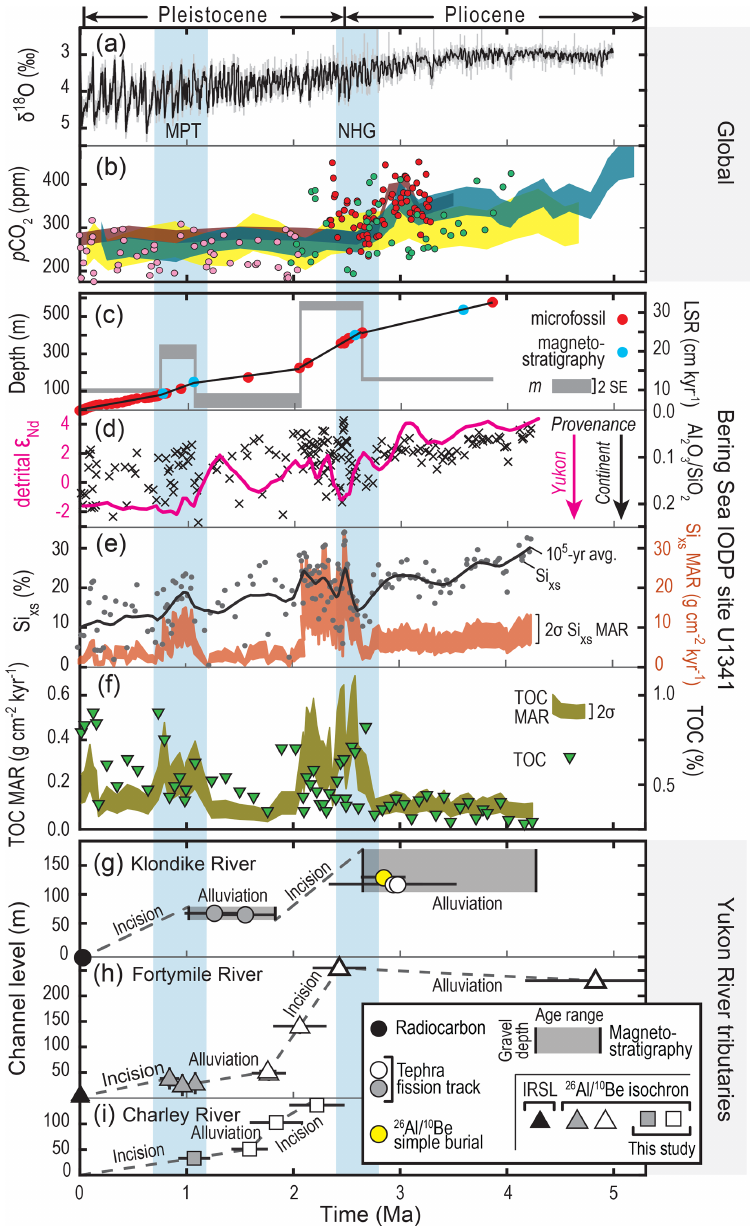
Figure 4. Late Cenozoic changes in global climate, Bering Sea sedimentation, and Yukon River tributary incision. (A) Global benthic δ 18 O (black line) and standard deviation (gray bars) (Ahn et al., 2017). (B) Atmospheric p CO 2 reconstructed from δ 11 B (red (Martínez-Botí et al., 2015), green (Bartoli et al., 2011), and pink (Hönisch et al., 2009) dots; blue envelope (Seki et al., 2010)) and alkenones (brown (Seki et al., 2010) and yellow (Pagani et al., 2010) envelopes). (C) Bering Sea integrated ocean drilling program (IODP) Site U1341 depth–age data (colored dots (Horikawa et al., 2015; Iwasaki et al., 2016)), regression model (black lines). Thick gray line plots regression model slope m and standard error (SE), which signify linear sedimentation rate (LSR) and uncertainty. (D) Detrital Al 2 O 3 / SiO 2 weight % ratio (black x ’s, higher ratios reflect more continental provenance (März et al., 2013)) and 10 5 yr moving average ε Nd values (magenta line, lower values reflect more Yukon River provenance (Horikawa et al., 2015)). (E) Silicate biomass inferred from weight % silica exceeding upper continental crust standard (Si x s ; gray dots (März et al., 2013)) and 10 5 yr moving average (black line), and Si x s mass accumulation rate (MAR; orange envelope). (F) Total organic carbon (TOC; inverted triangles (März et al., 2013)) and TOC MAR (olive envelope). (G) Klondike River terrace ages over height above floodplain after composite magnetostratigraphy (Froese et al., 2000), tephrochronology (Westgate et al., 2003), cosmogenic burial dating (Hidy et al., 2013, 2018) and floodplain radiocarbon ages (Lowey, 2006). (H) Fortymile River terrace ages over height above the Middle to Late Holocene-aged floodplain (Bender et al., 2020). (I) Charley River terrace ages over height above the modern channel. MPT – Middle Pleistocene climate transition; NHG – Northern Hemisphere glaciation intensification.